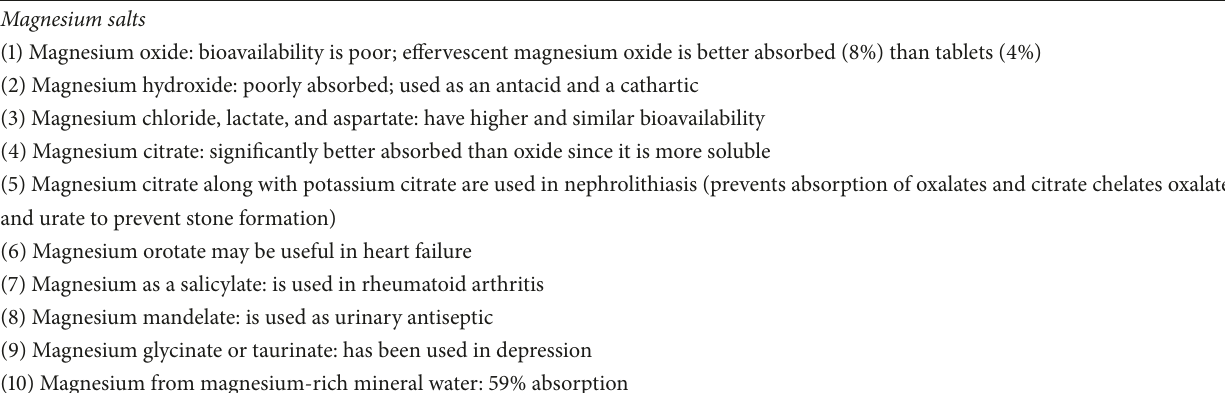
Table 6: Selected magnesium sources, supplement bioavailability/pharmacodynamics properties, and therapeutic uses. Magnesium salts